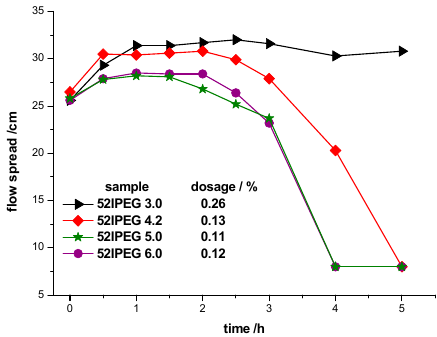
Figure 9. Mini slump results of cement paste added 52IPEG series PCEs.